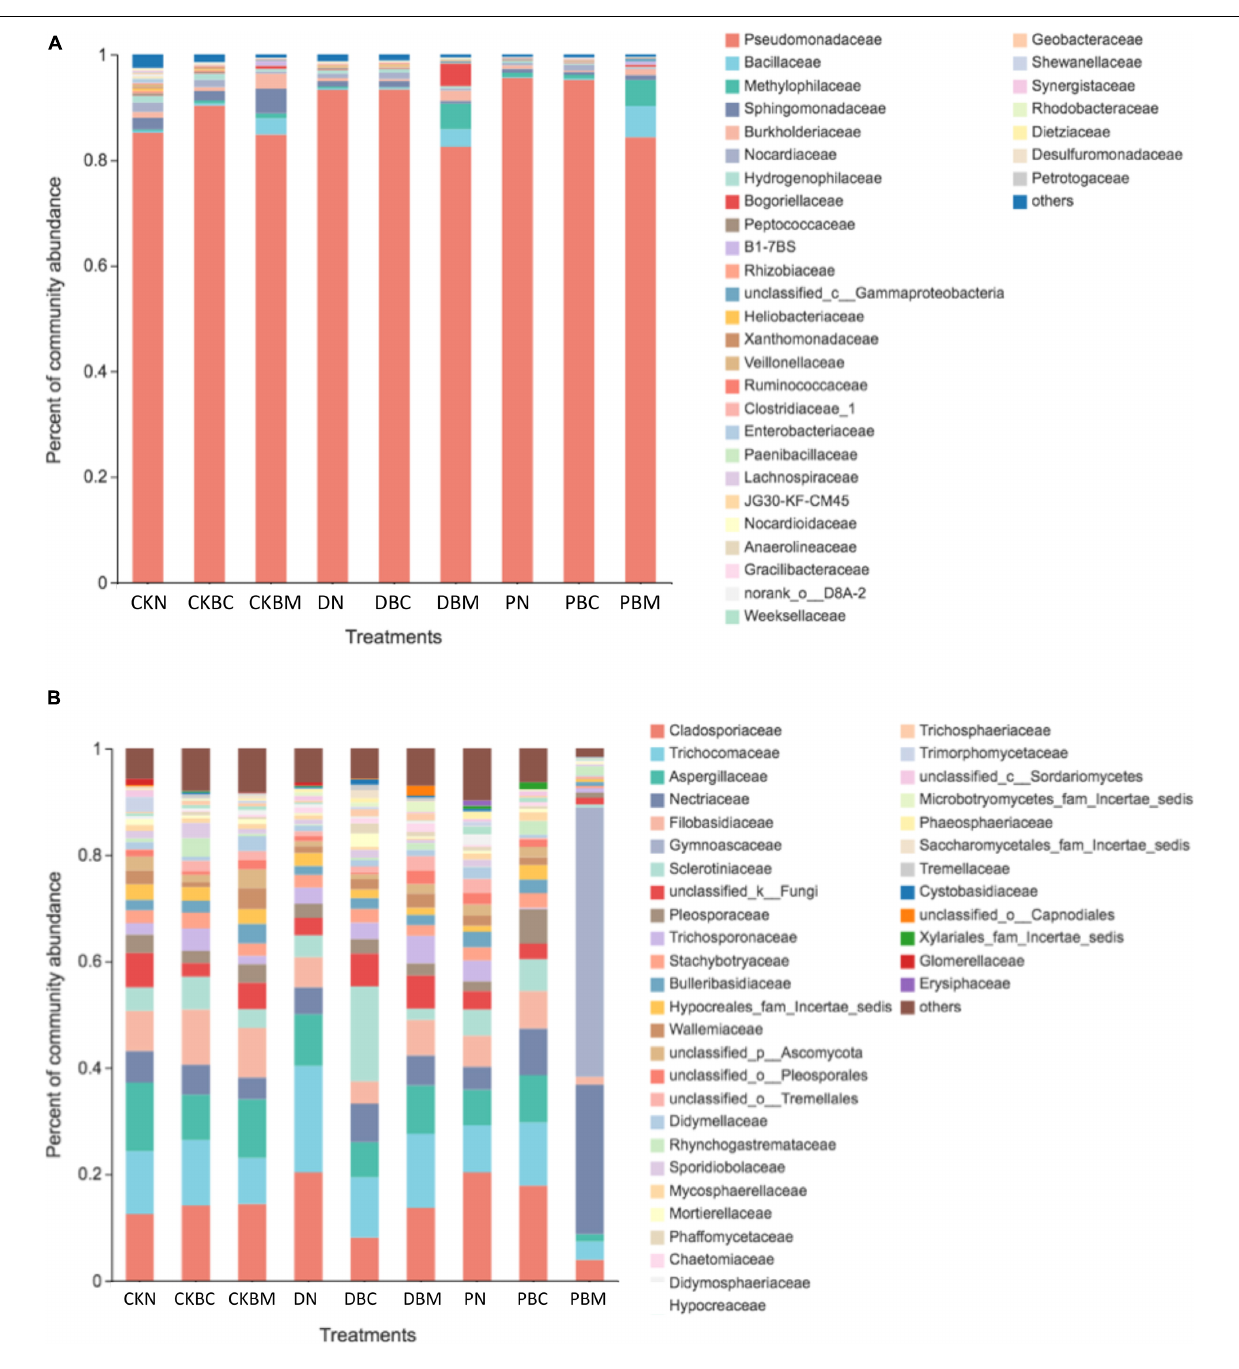
FIGURE 5 | Community composition at the family level: (A) bacteria and (B)